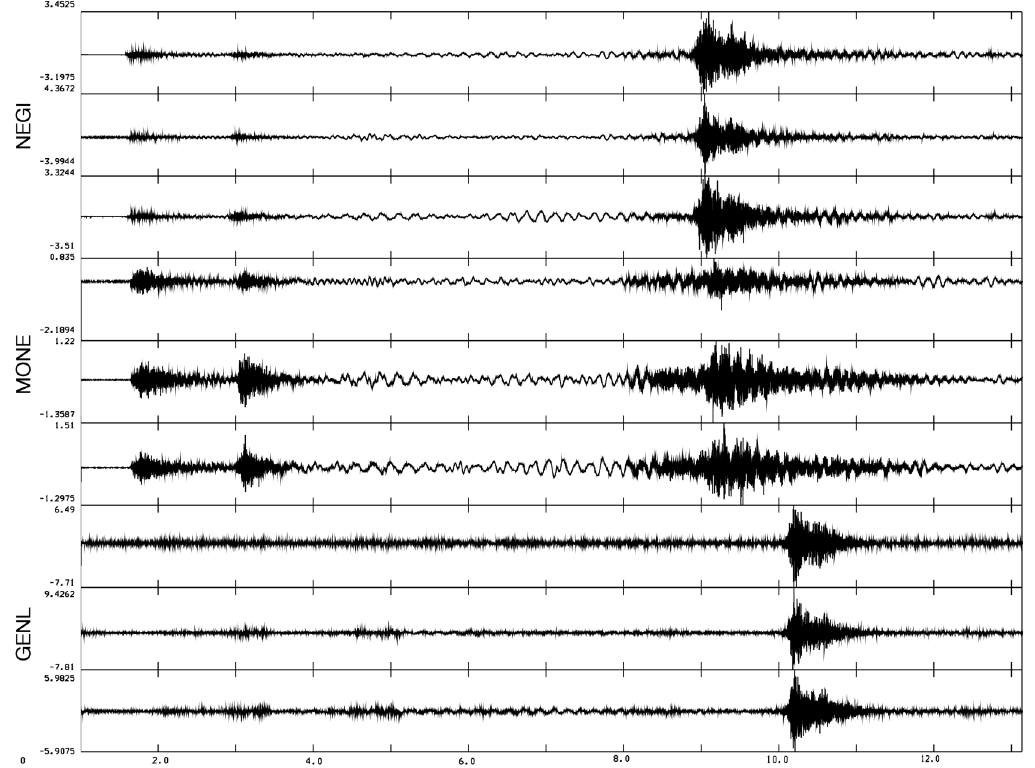
Fig. 3. Acceleration experienced by three sites NEGI, MONE and GENL (in mm/s 2